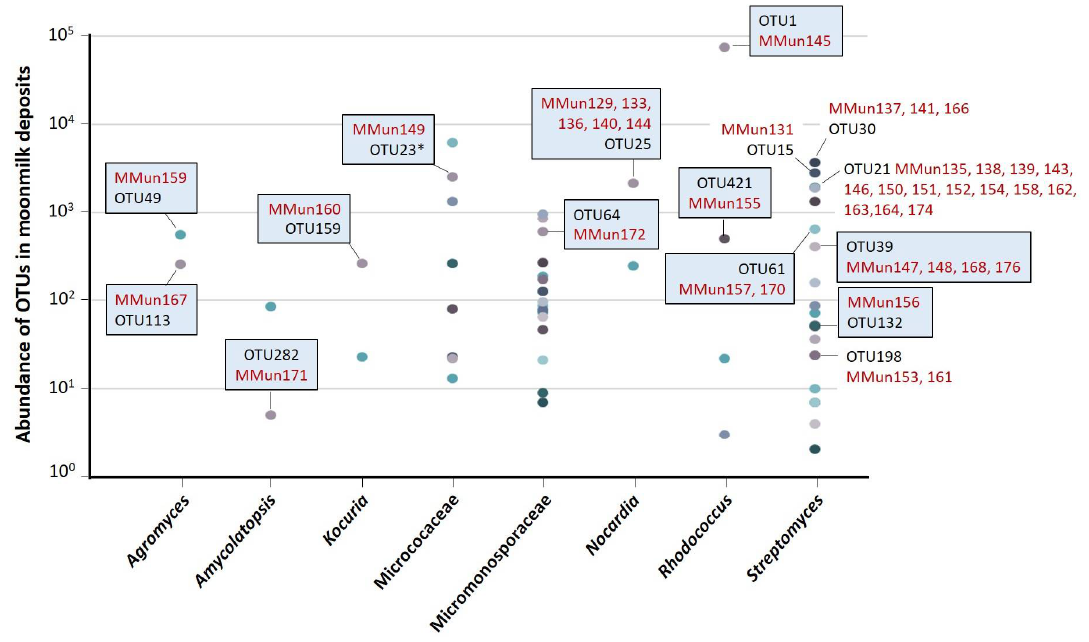
Figure 5. Membership of MMun strains isolated in this study to the actinobacterial operational taxonomic units (OTUs) identified by the high-throughput sequencing (HTS) metagenetic study. OTUs in blue boxes are those for which we isolated a first representative strain in this study. Note that for MMun149 and MMun172, the search of their associated OTU was performed at the family level (Micrococcaceae and Micromonosporaceae) and not at the genus level, as the HTS study [13] did not allow us to unambiguously assign the sequences of the 16S rRNA V6–V7 amplicons to the Micrococcus and Micromonospora genera. Symbol: *, due to the phylogenetic divergence of its V6–V7 region and based on the full sequence of its 16S rRNA gene (extracted from the genome sequence), MMun149 was manually affiliated to OTU23 even though its “closest” OTU in the tree was OTU141 (Figure S2).